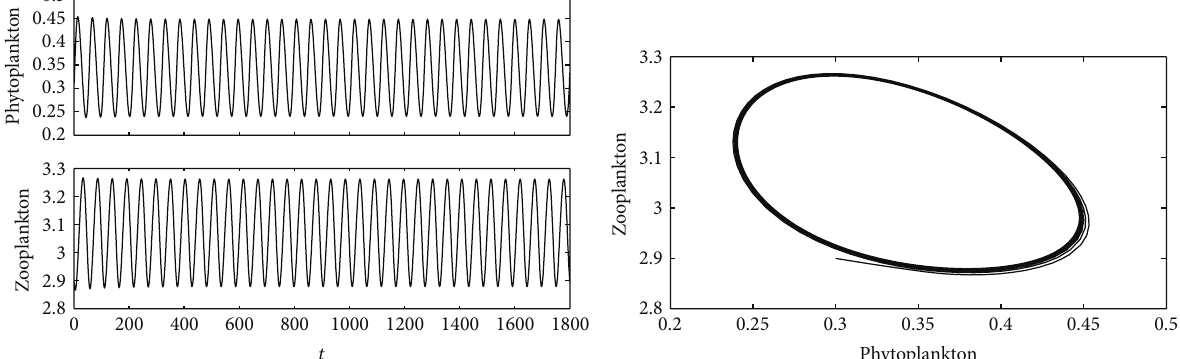
Figure 3: Behavior and phase portrait of system (4) when 𝜏 = 𝜏 0 = 3.5 . Hopf bifurcation occurs from the interior equilibrium 𝐸 ∗ 1 . The initial value is (𝜙(0),𝜑(0)) = (0.33, 3.1) .